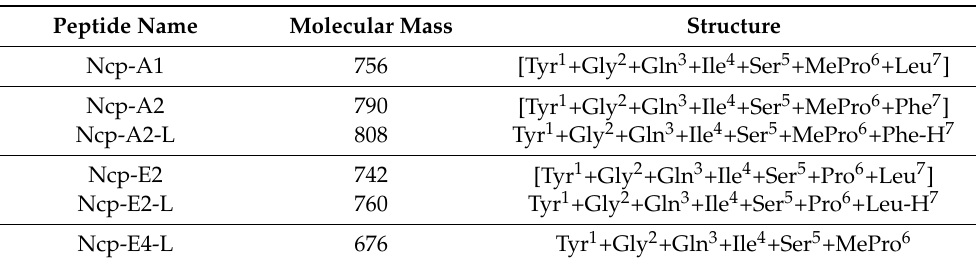
Figure 1. ROESY and HMBC correlations in nostocyclopeptide Ncp-A2-L. Table 1. Structures of six nostocyclopeptide-variants isolated from Nostoc edaphicum CCNP1411 as pure compounds.